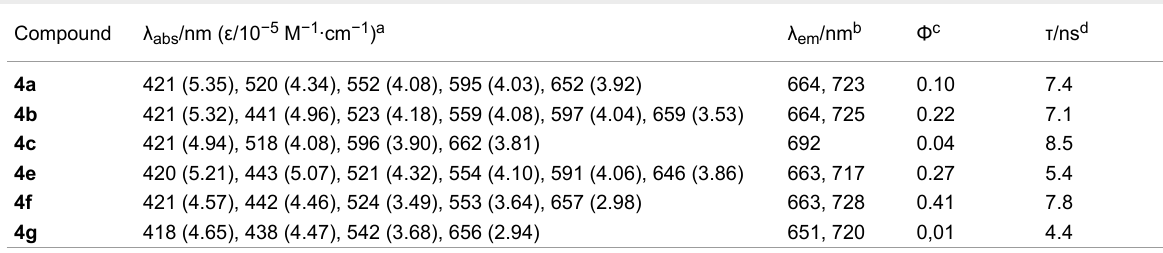
Table 2: Photophysical properties of hybrid compounds.